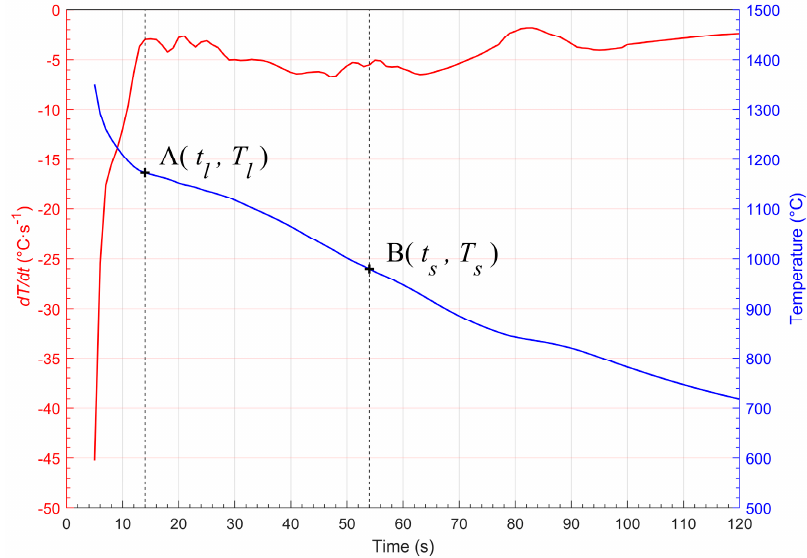
Figure 21. The cooling curve and the first-order differential curve of point i2.